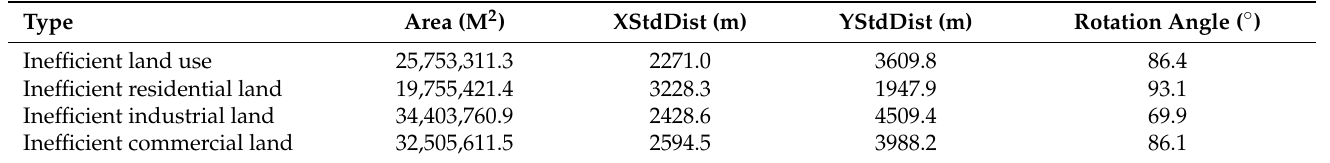
Figure 3. Standard deviation ellipse of urban inefficient land use location distribution in Dali Central City. (( a ). Inefficient land; ( b ). Inefficient residential land; ( c ). Inefficient industrial land; ( d ). Inefficient commercial land; ( e ). Overall situation). Table 6. Standard deviation ellipse parameters of inefficient urban land use location